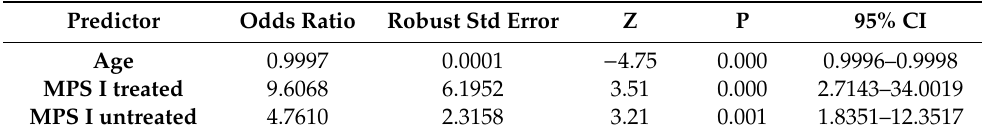
Table 19. Scent discrimination mixed e ff ects logistic regression model. Analysis of MPS I a ff ected groups compared to normal group for choice (correct versus incorrect) at each session x trial and